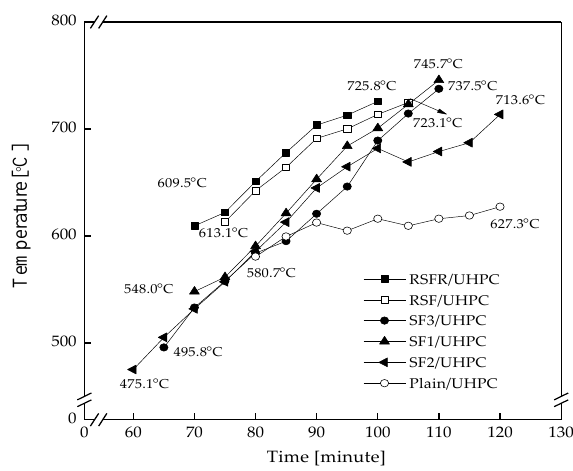
Figure 11. Temperature–time curves of all UHPC types during explosive spalling.